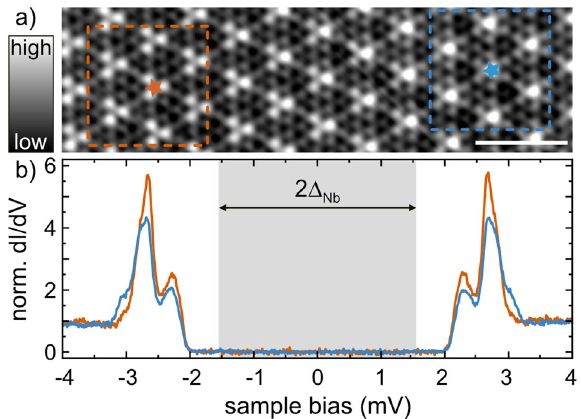
Fig. 1 Scanning tunneling microscopy measurements. a Constant- current image of a clean NbSe 2 surface (recorded with a Nb tip at a set point of 10 mV, 100 pA; the scale bar is 2 nm) to illustrate the smooth evolution of the CDW with respect to the atomic lattice. The frames highlight regions where the CDW maxima fall on a hollow site (orange) or on a Se atom (blue). b Differential-conductance d I /d V spectra taken at the positions indicated by stars in ( a ), recorded in constant-height mode (feedback was opened at the position of the blue spectrum for both traces with a set point of 5 mV, 250 pA and a modulation of 15 μ V rms ).